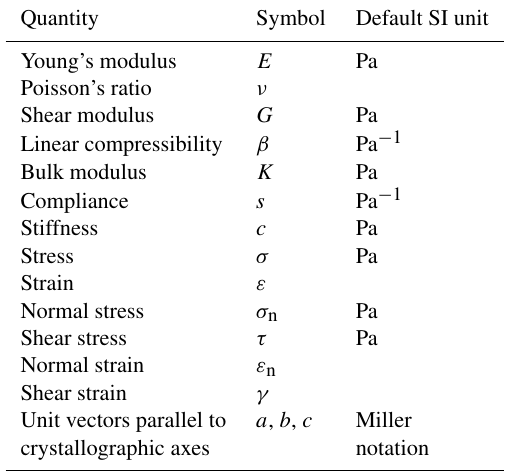
Table 1. List of symbols and terms used in this paper, together with their default units (if any).